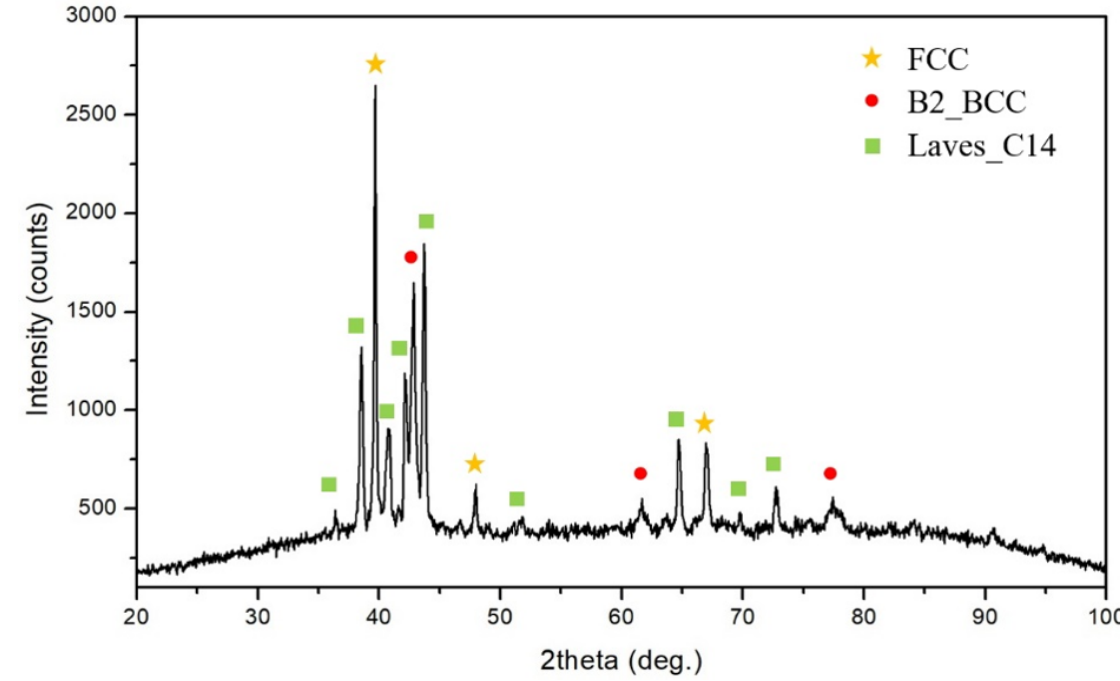
Figure 3. XRD pattern of the CuFeTiZrNi 0.5 alloy.